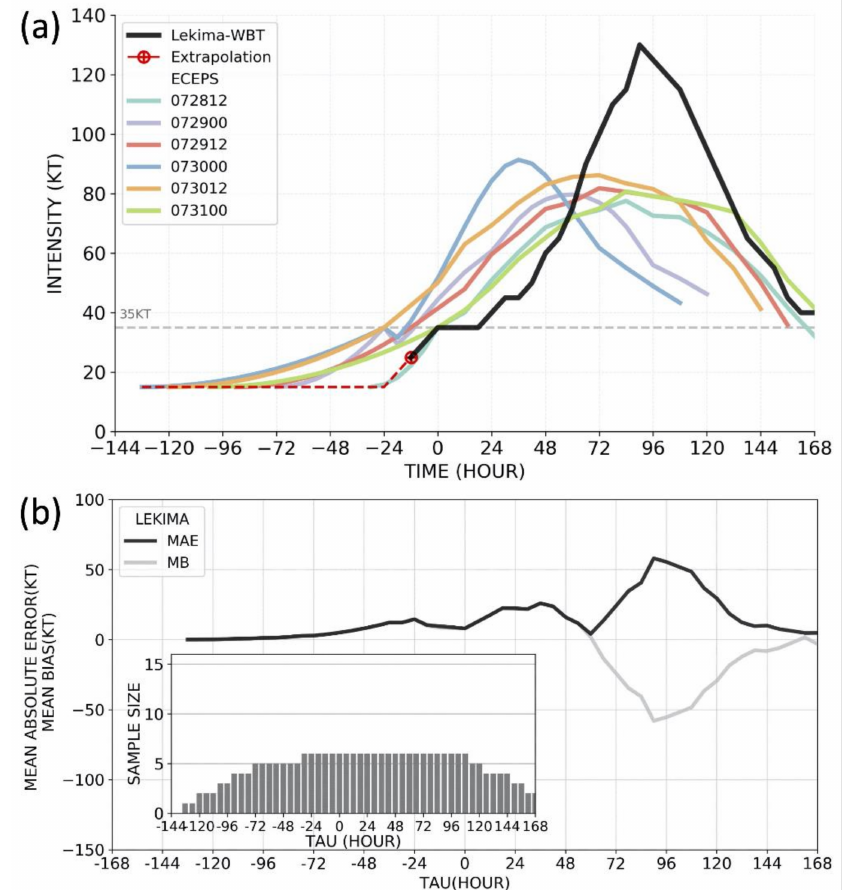
Figure 5. ( a ) Modified WAIP intensity (knots) forecast verifications for the ECEPS-predicted T2F (35 kt) as in Figure 4b, except for the pre-TY Lekima (2019) circulations. ( b ) Intensity MAEs (solid line) and intensity MBs (gray line) as in Figure 4d,f except combined here for pre-TY